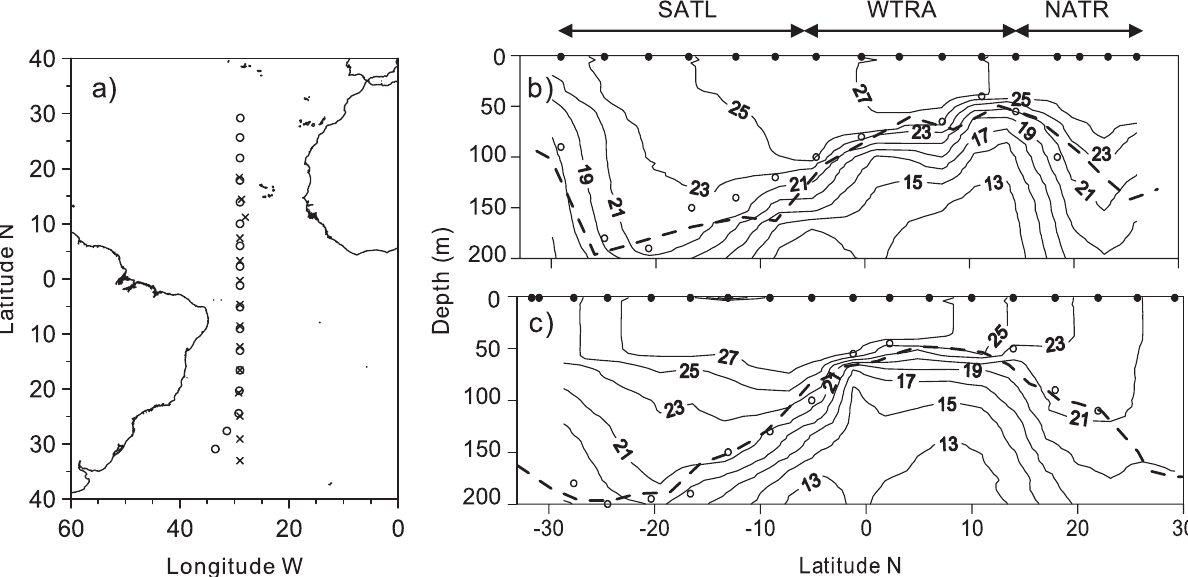
Fig . 1. – Cruise tracks and location of the sampling stations (a). Crosses, Trynitrop 2007; white circles, Trynitrop 2008. Contour plots repre- sent water temperature (ºC), the dotted line indicates the nitracline and white circles indicate the phosphocline during the Trynitrop 2007 (b) and Trynitrop 2008 (c) cruises. Marks in the top axis of the contour plots show the CTD stations. SATL: South Atlantic Tropical gyre; WTRA: Western Tropical Atlantic province; NATR: North Atlantic Tropical